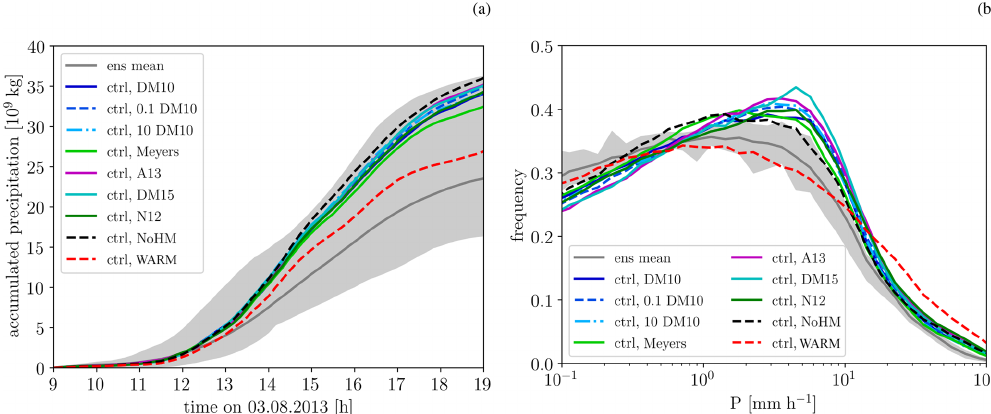
Figure 4. (a) Time series of accumulated surface precipitation. (b) Precipitation rate distribution (excluding non-raining grid points). The dark grey shading shows the spread of the 10 ensemble members with perturbed initial conditions. The grey line represents the ensemble mean, and the various coloured lines represent simulations with different heterogeneous freezing parameterization, pure warm-phase microphysics, and no Hallett–Mossop process (colours according to the